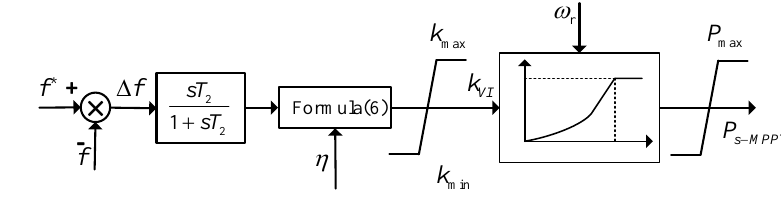
Figure 4. Schematic diagram of the accessional power outer-loop control.